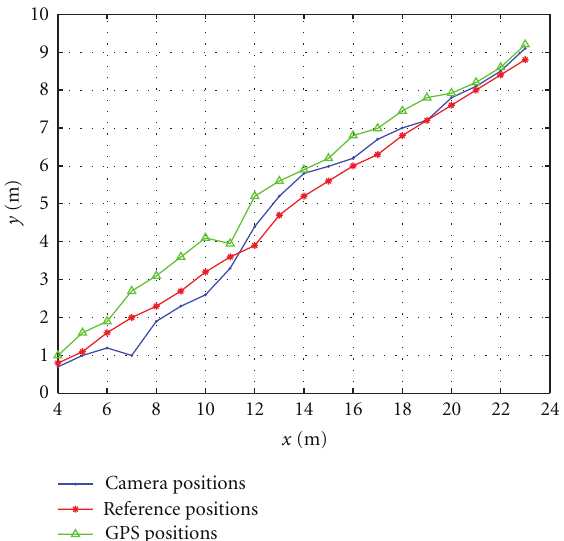
Figure 13: Predicted and estimated localization errors (on x